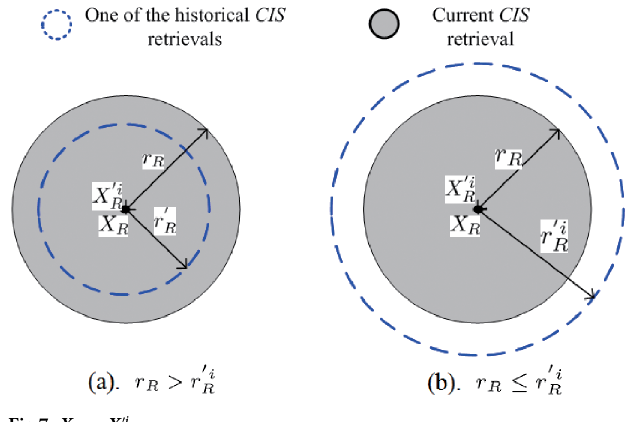
Fig 7. X ¼ X 0 i . R R